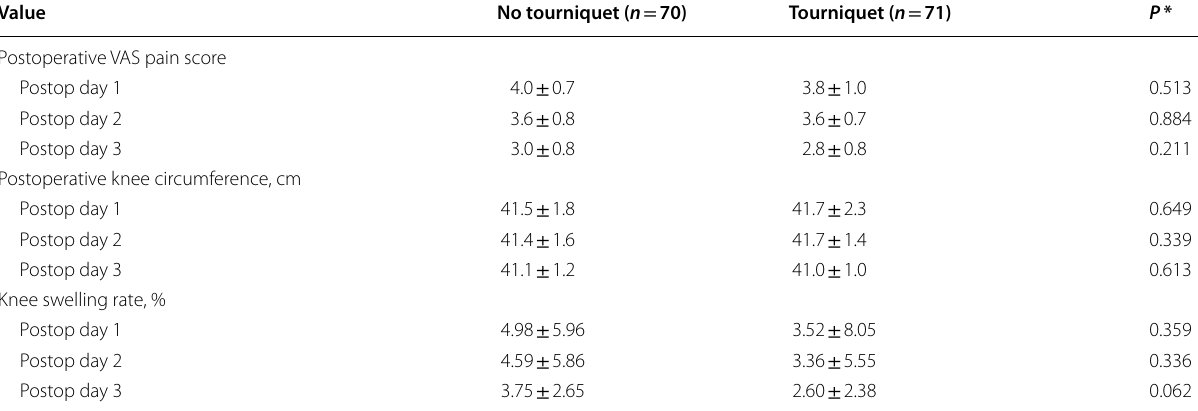
Data are shown as mean ± SD unless otherwise